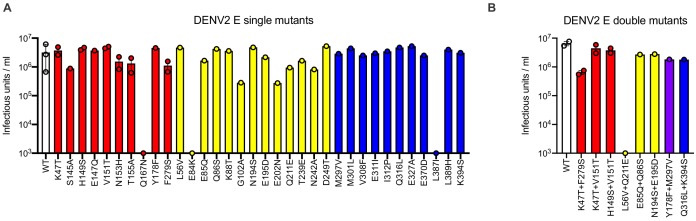
Effect of DENV2 E protein mutations on infectious titer.Infectious titers of DENV2 reporter virus encoding (A) single or (B) double E protein mutations. For each graph, white bars show the infectious titer of WT DENV2, and red, yellow, and blue bars represent mutations in DI, DII, and DIII, respectively. In (B), the purple bar represents a paired mutation at one residue in DI (Y178F) and another in DIII (M297V). Titers are based on one or two independent virus preparations, as indicated by data points. Where indicated, error bars represent the range of infectivity from 2 to 3 independent virus preparations.